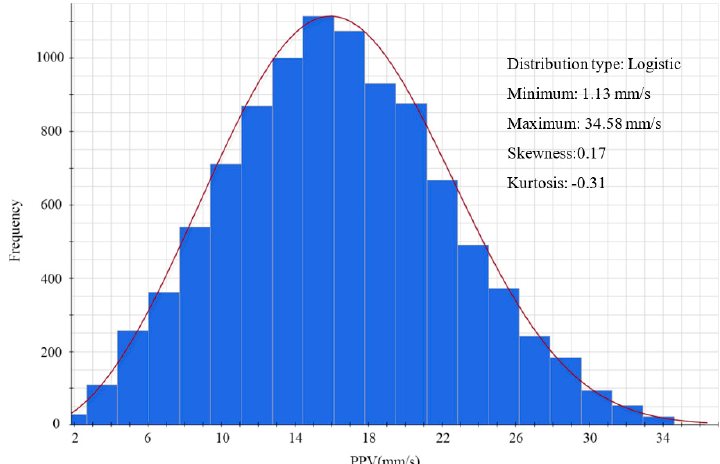
Figure 7. Obtained frequency of PPV results using Monte Carlo simulation.